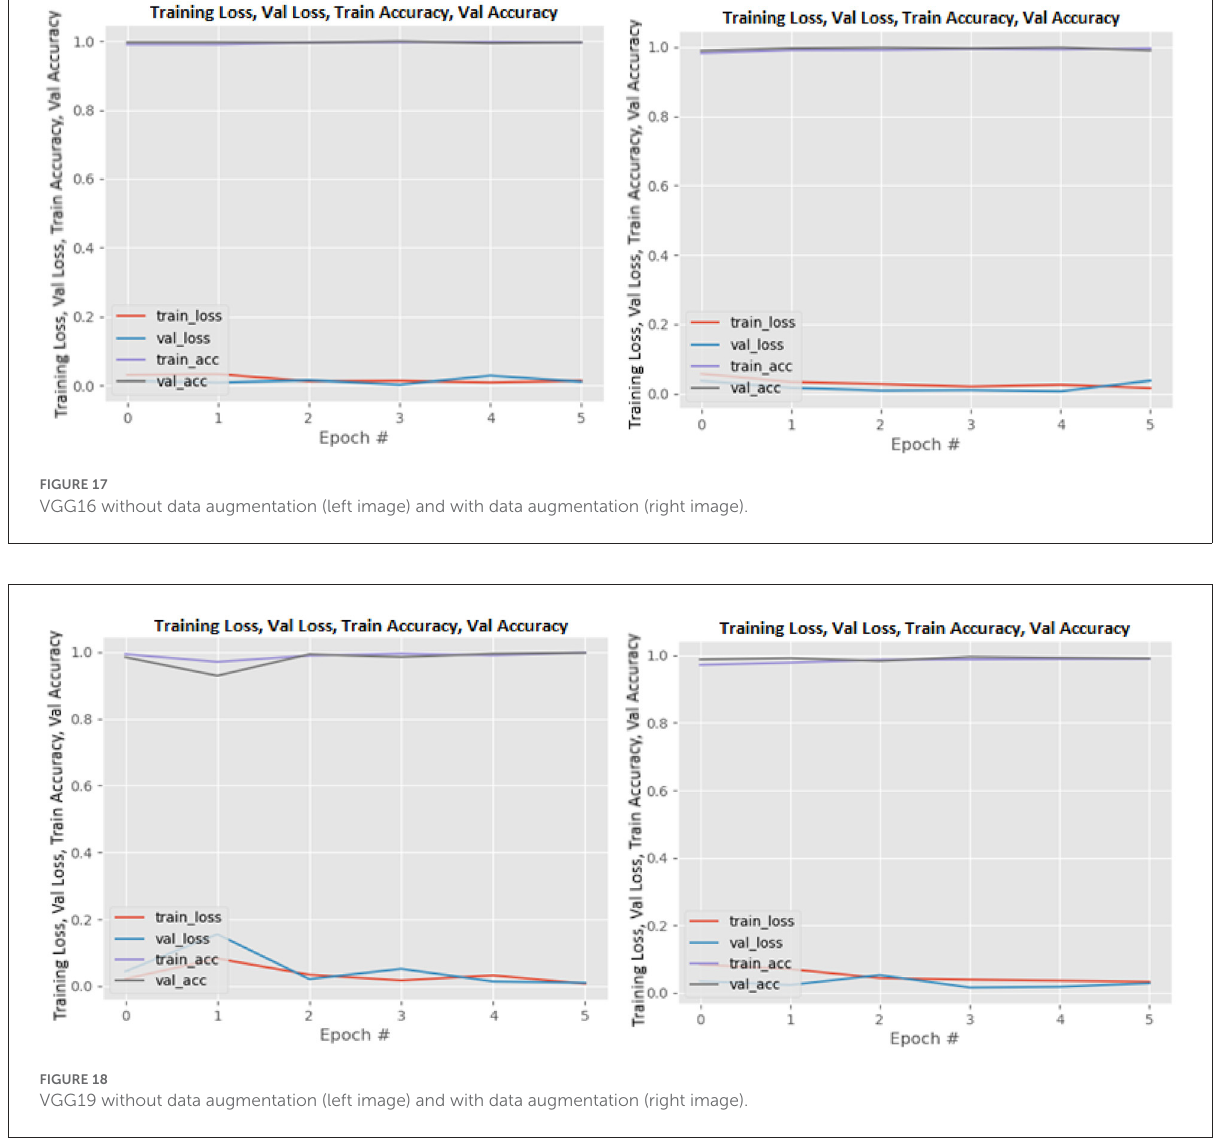
a dataset with 6,432 lung chest X-ray images, and it executed in 30s. Moreover, the model achieved an accuracy of